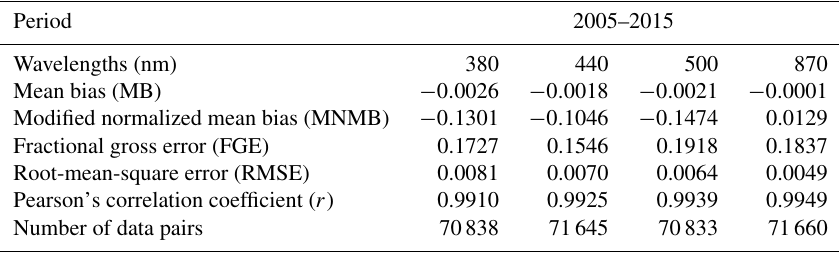
Table 5. Basic skill scores from the AOD intercomparison between GAW-PFR and AERONET-Cimel V2 for the period 2005–2015. The skill score definitions are found in Huijnen and Eskes (2012).